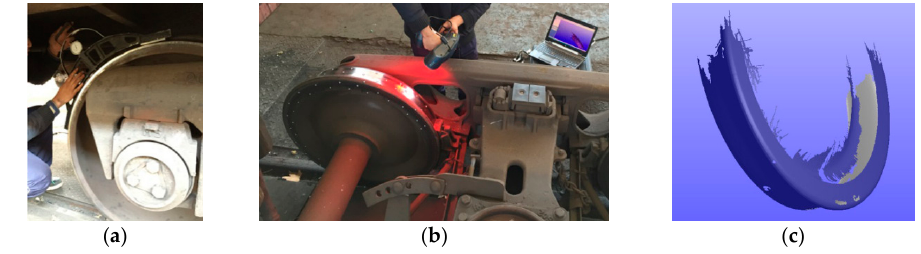
Figure 22. One set of laser images of a wheel.